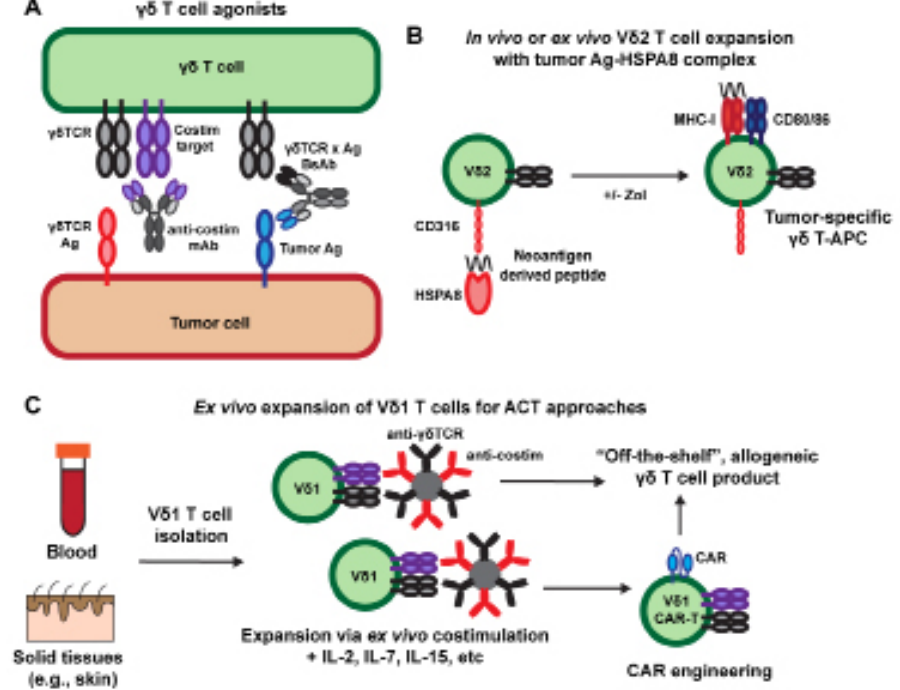
Figure 2. Targeting γδ T cells for cancer immunotherapy. A) γδ T cell agonists include monoclonal antibodies (mAb) and